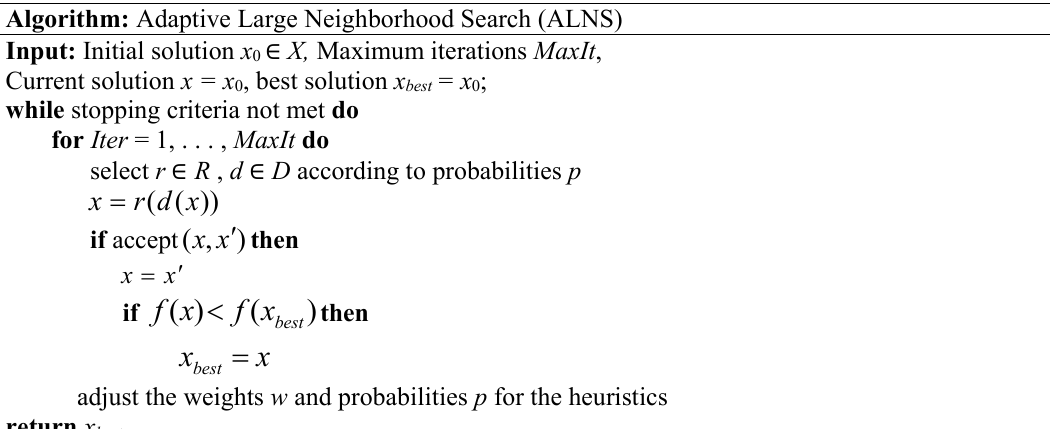
Fig. 1. Pseudo-code for the ALNS algorithm for the reliable hub location problem under hub